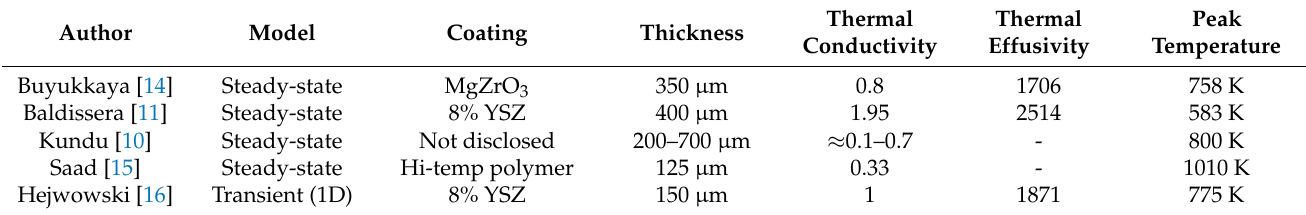
Table 1. Literature review for thermal barrier coating (TBC)